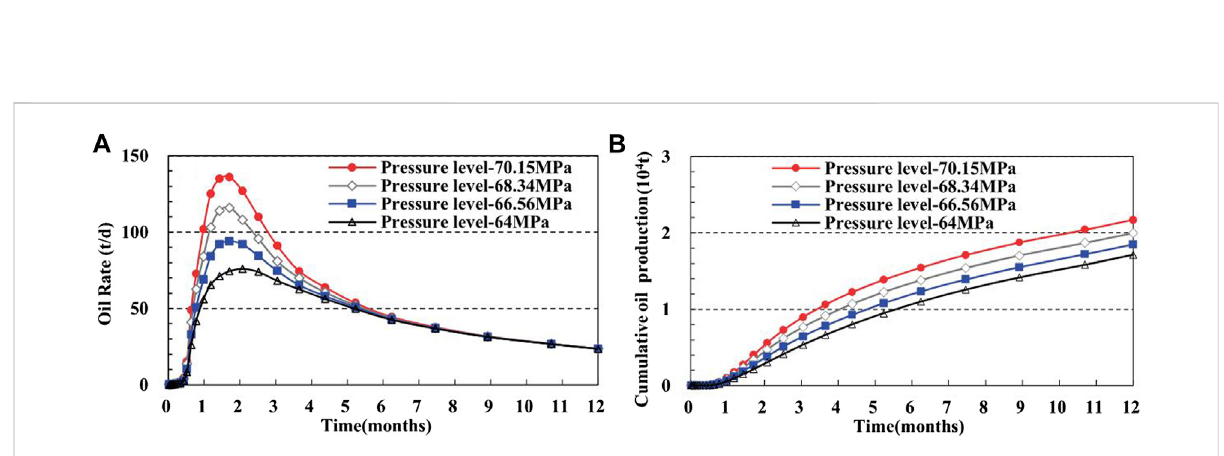
FIGURE 3 In fl uence of formation pressure level on initial